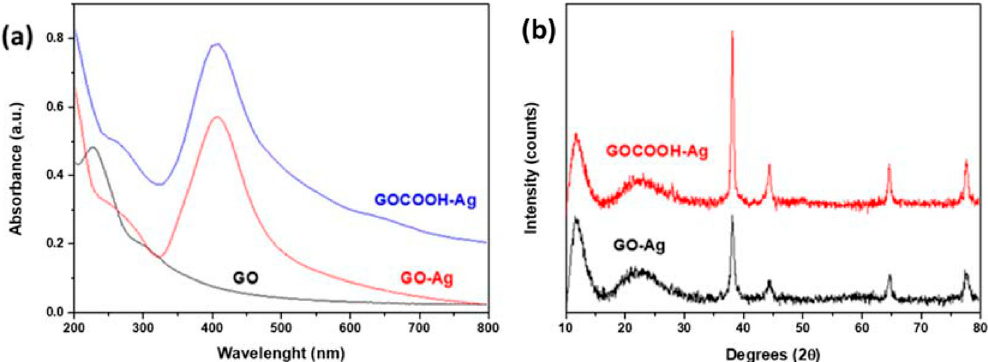
Figure 2. ( a ) UV–Vis absorption spectra of GO (black), GO-Ag (red) and GOCOOH-Ag (blue); ( b ) XRD spectrum for GO-Ag (black) and GOCOOH-Ag